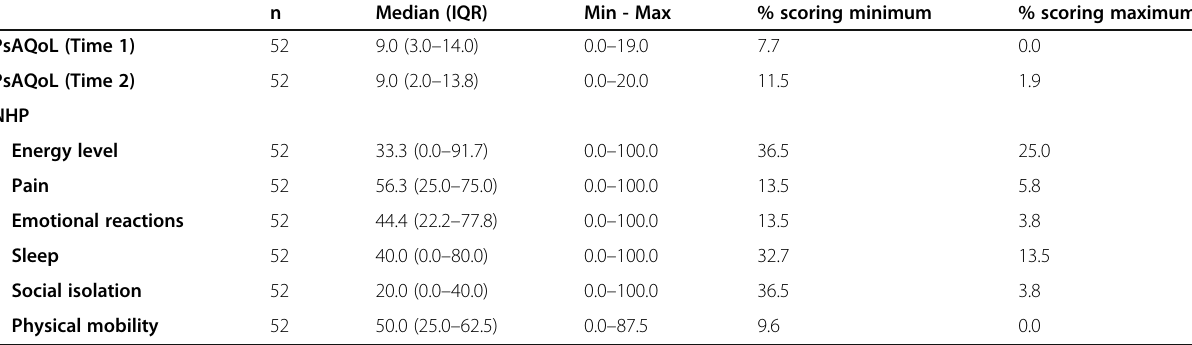
Table 2 Descriptive statistics for the PsAQoL and NHP sections